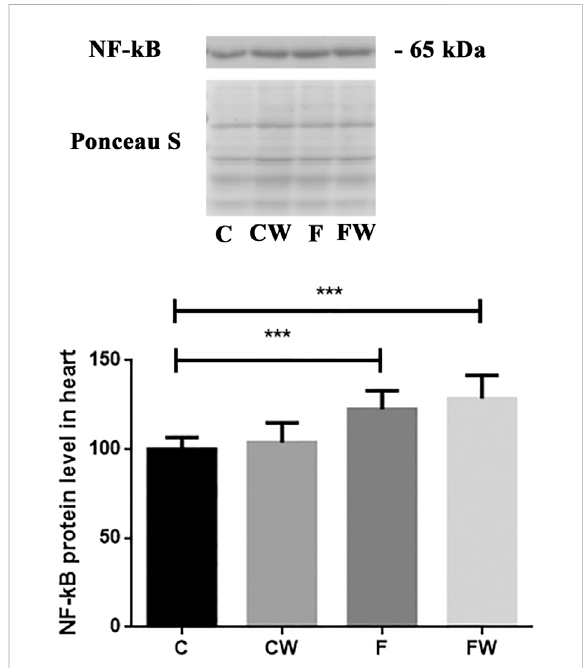
FIGURE 5 Effects of fructose-rich diet and walnut supplementation on NF- κ Bproteinlevel inheartofexperimentalrats. Values aremeans withstandarddeviationsrepresentedbyverticalbarsfor3samples, each consisting of 3 pooled hearts of the same group. C — animals on standard laboratory chow, F — animals fed a fructose-rich diet, CW — animals on standard laboratory chow and walnut supplementation, FW — fructose-fed animals on walnut supplementation, *** p <